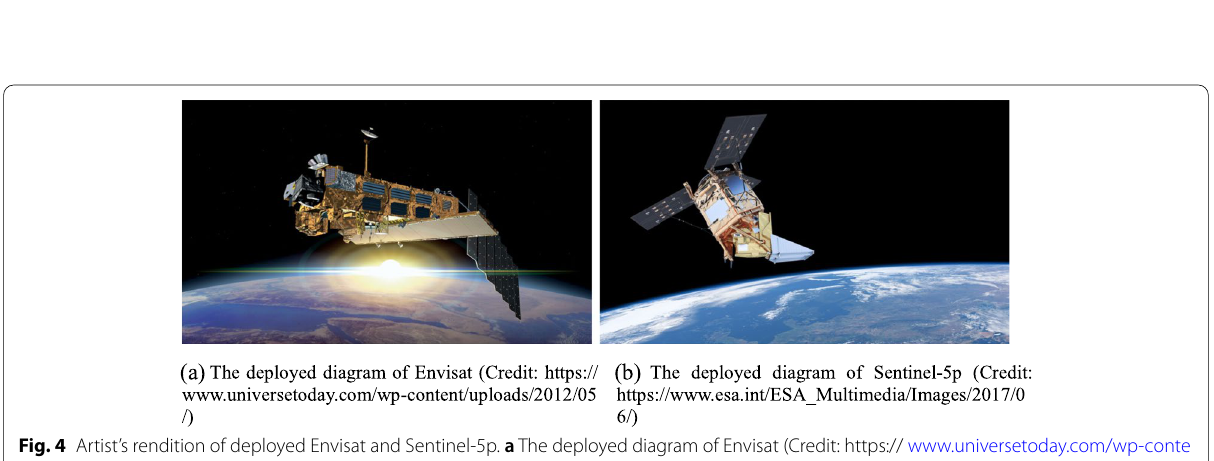
Fig. 3 Artist’s rendition of deployed GOSAT-2 and OCO-2. a The deployed diagram of GOSAT-2 (Credit: http:// copja pan. env. go. jp/ cop/ cop24/ pavil ion/ 05/). b The deployed diagram of OCO-2 (Credit: https:// dev. space news. com/ wp- conte nt/ uploa ds/ 2014/ 08)